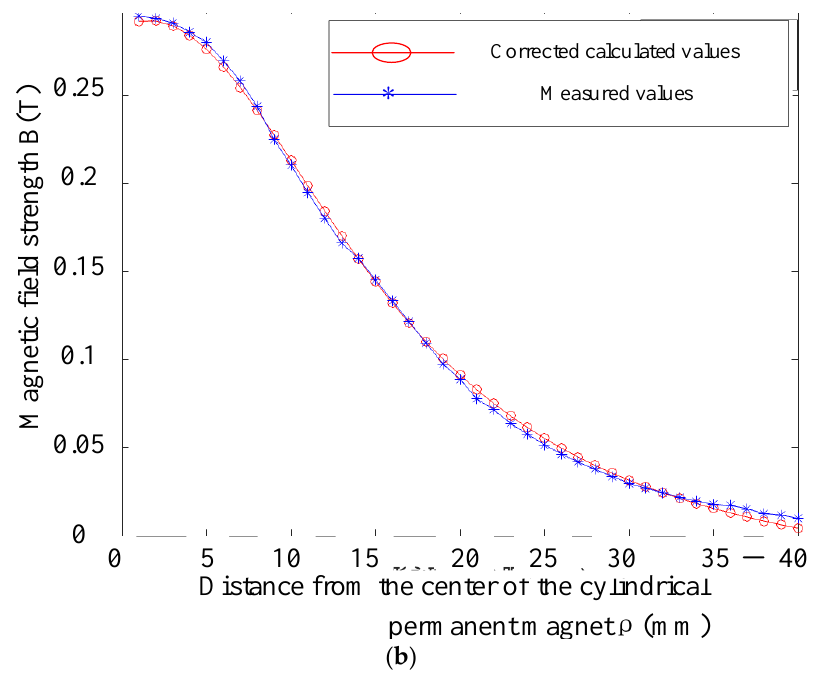
Figure 9. Comparison between calculated and measured values after modification. ( a ) Magnetic field 10 mm away from the upper-end face. ( b ) Magnetic field 15 mm away from the upper-end face.